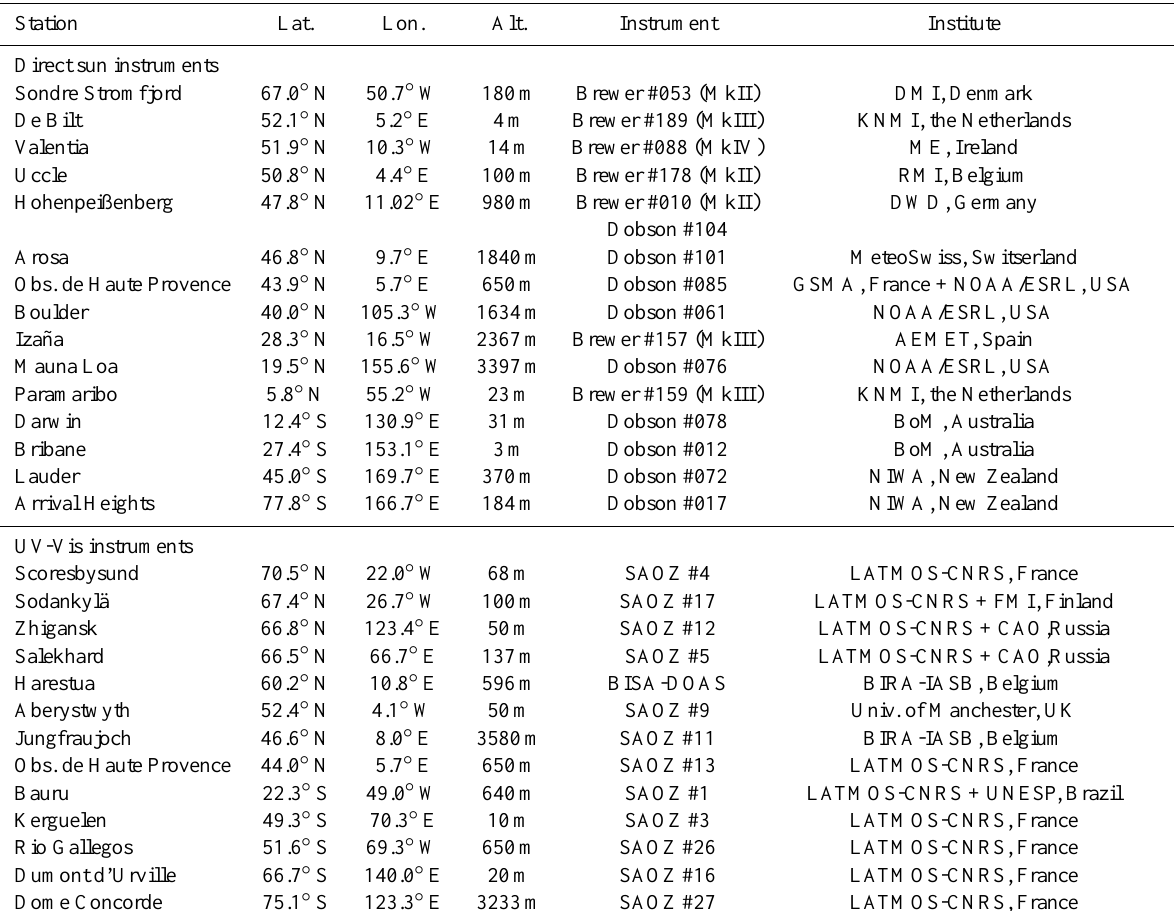
Table 1. Overview of the ground-based instruments used here as a source of reference data. Station Lat.